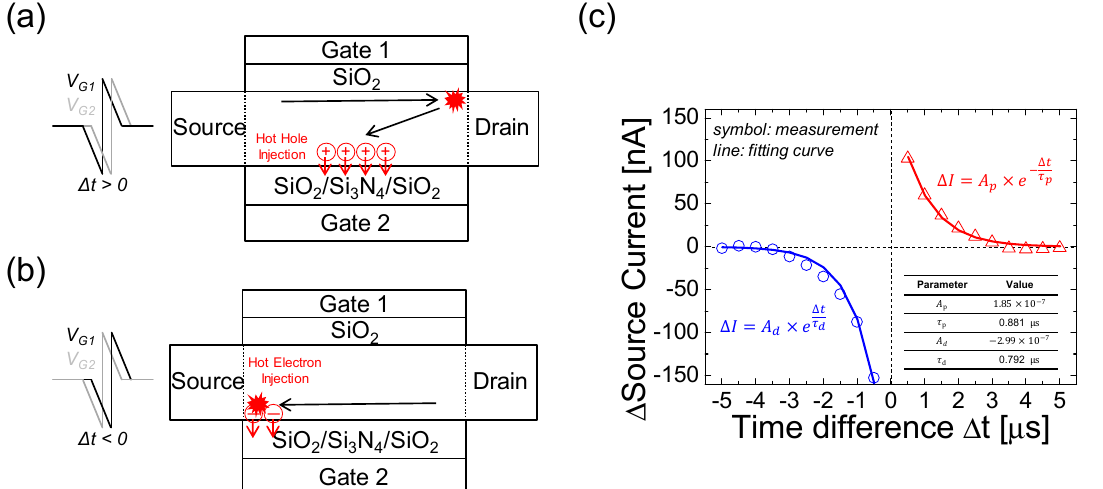
Figure 1. Weight adjustment of the silicon-based four-terminal synaptic transistor by: ( a ) Hot hole injection (potentiation) and ( b ) hot electron injection (depression); ( c ) measured spike-timing-dependent plasticity (STDP) characteristic and the fitting curve.